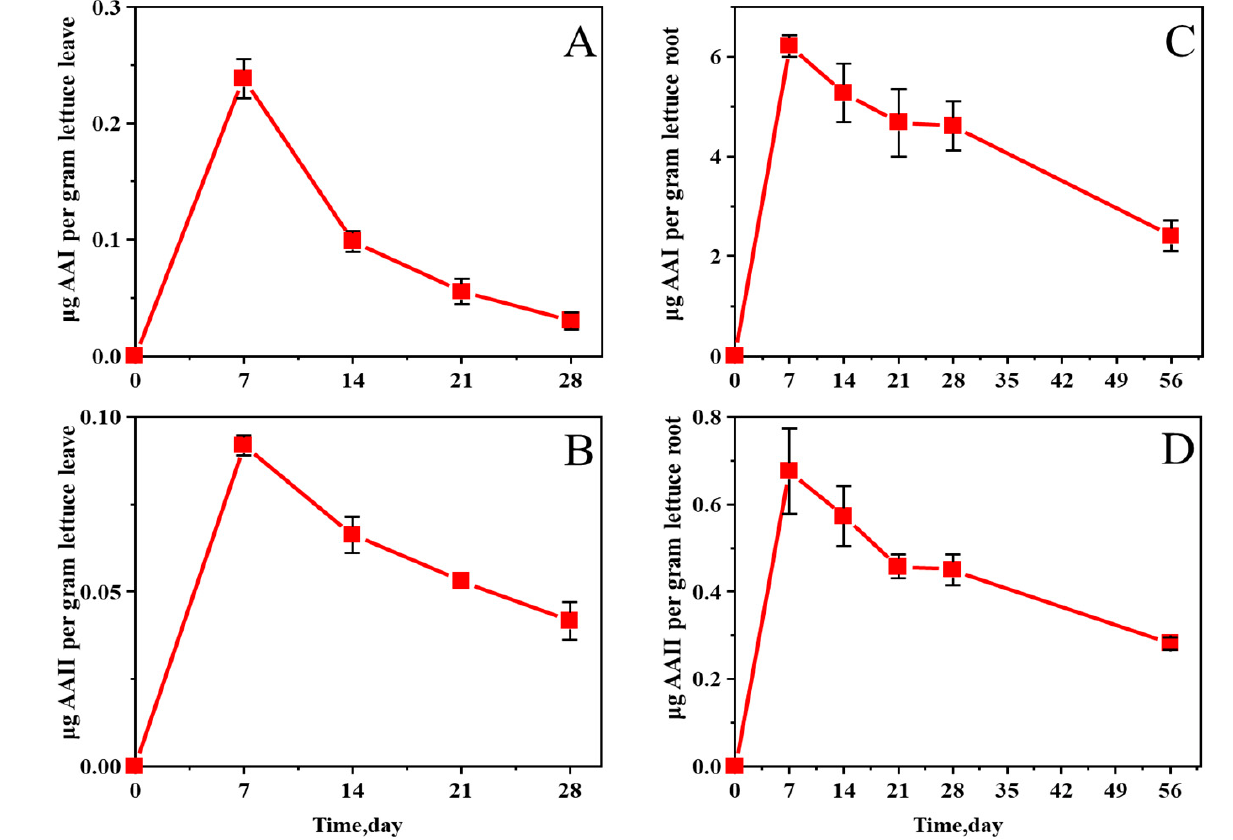
Figure 3. Changes in AA I ( A ) and AA II ( B ) concentrations in lettuce leaves and AA I ( C ) and AA II ( D ) in roots grown in AA-contaminated soil.